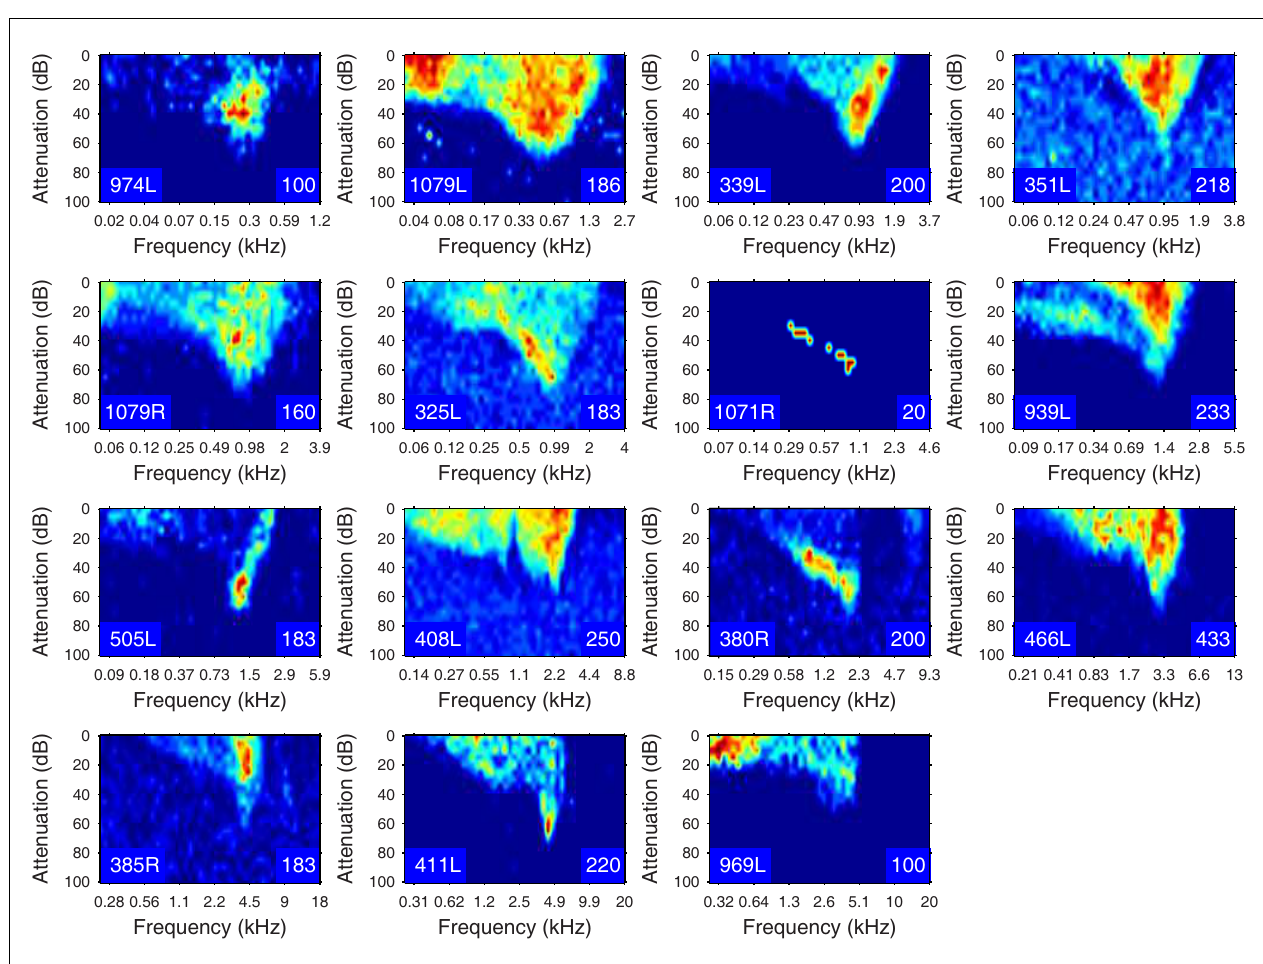
from blue (zero response) to red (maximum response).The number in the bottom right hand corner of each panel for this and the next figure indicates the maximum firing rate to which the plot is scaled